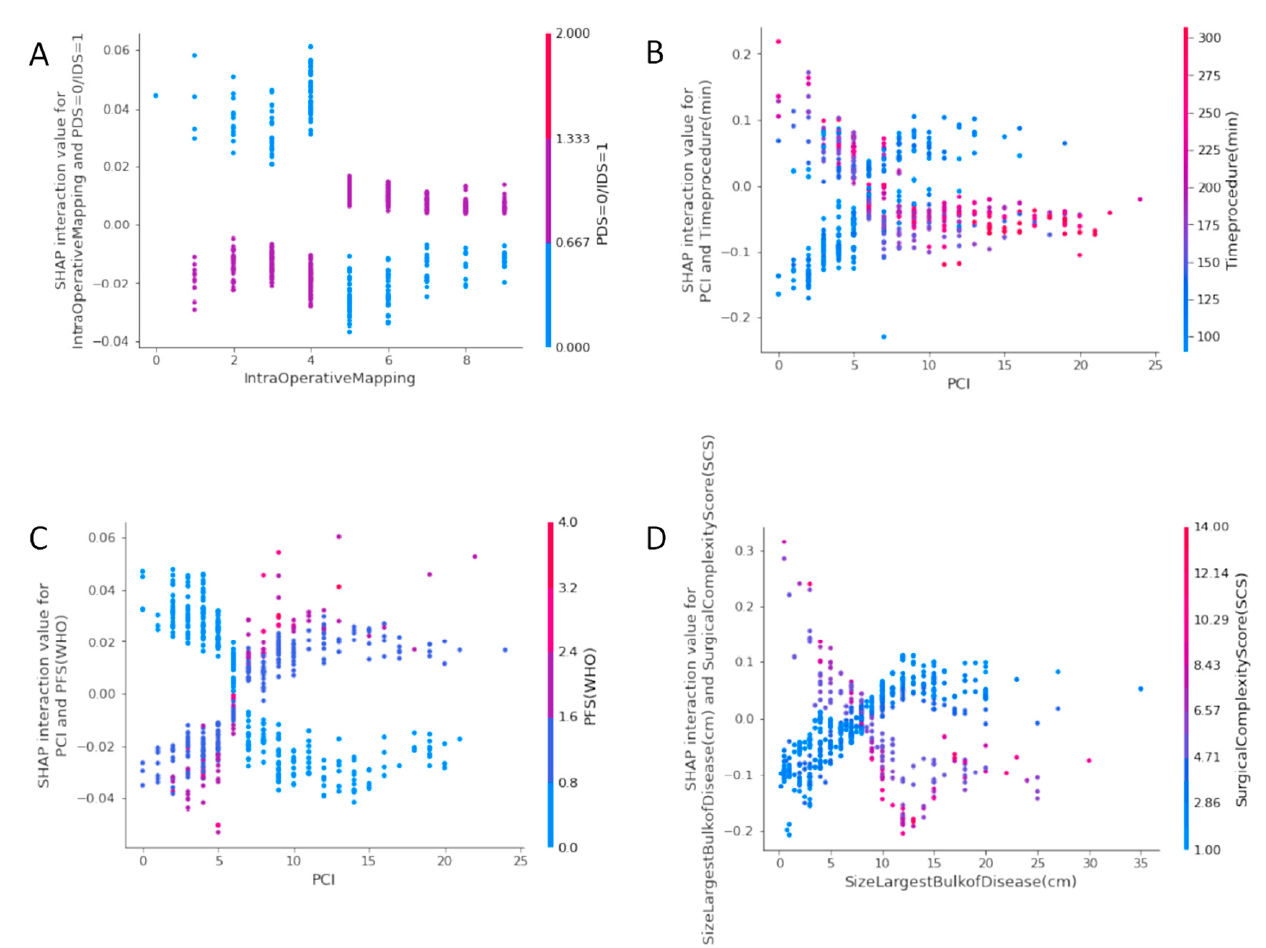
Figure 4. SHAP Interaction Value Dependence plots: ( A ) IMO score with type of surgery ( B ) PCI with time of the procedure ( C ) PCI with ECOG status ( D ) Size of largest tumor deposit with SCS.